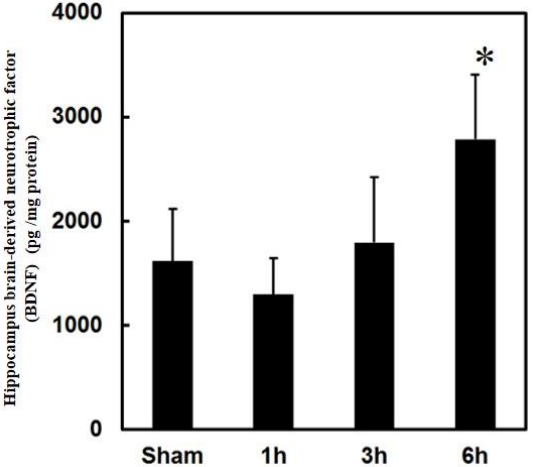
Figure 7. E ff ects of PPTg DBS on neurotrophic factor brain-derived neurotrophic factor (BDNF) expressions. Illustration of brain-derived neurotrophic factor levels in hippocampal tissue were determined at hours 1, 3, and 6-time intervals. Data were presented as mean ± SD ( n = 6). Significant di ff erences between groups were analyzed using one-way ANOVA. * p < 0.05 was considered statistically significant compared with the sham